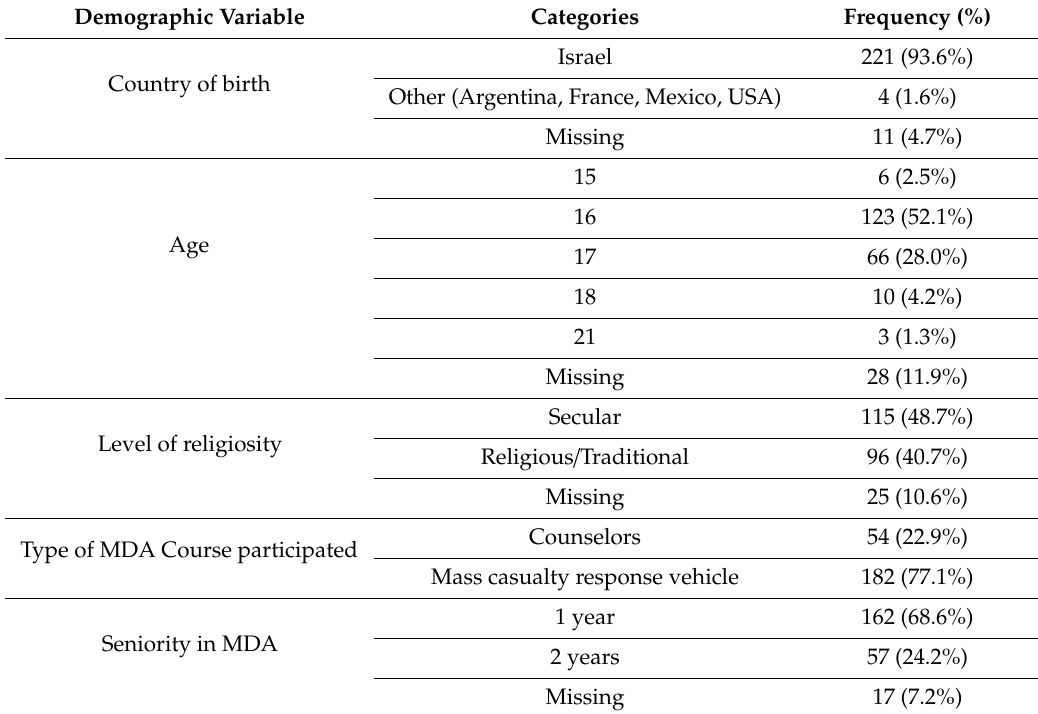
Table 1. Demographic characteristics of the study